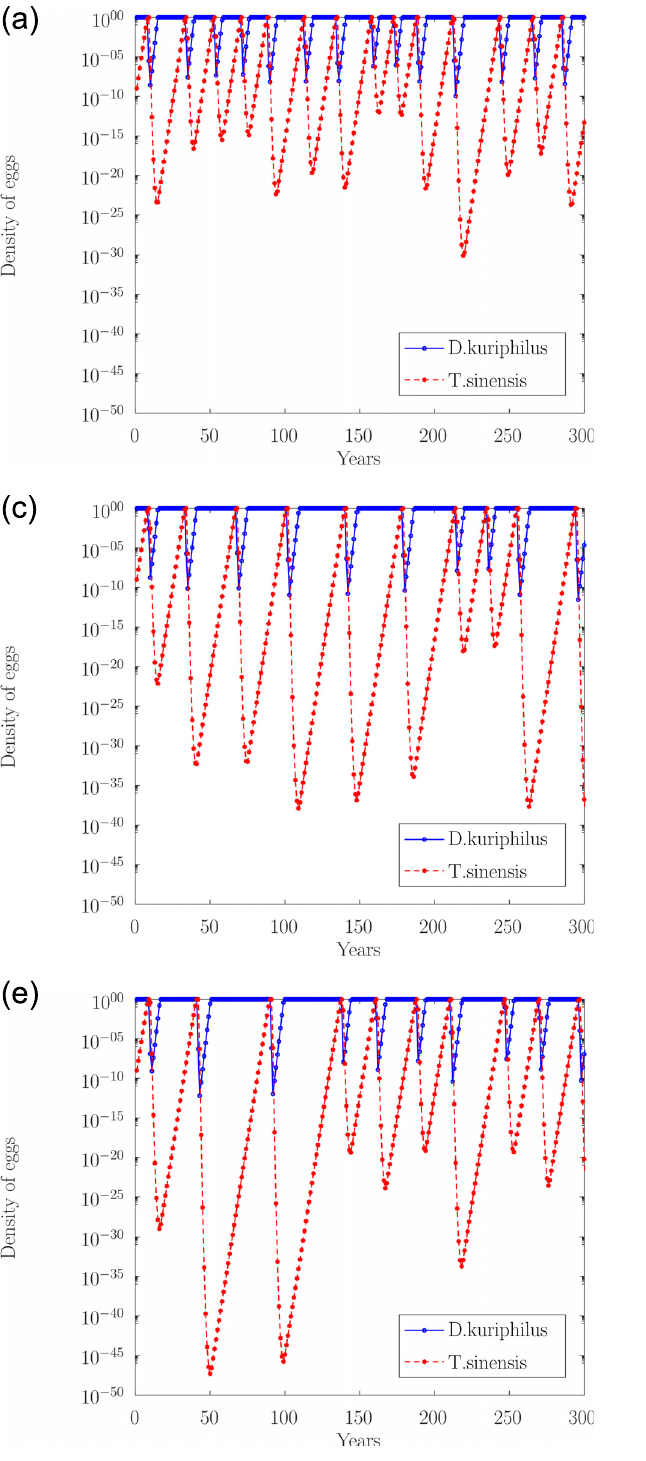
Fig 4. Temporal evolution of the egg density in function of the overwintering survival rate of D. kuriphilus . A logarithmic scale is used to highlight the low density reached by the two insect species.